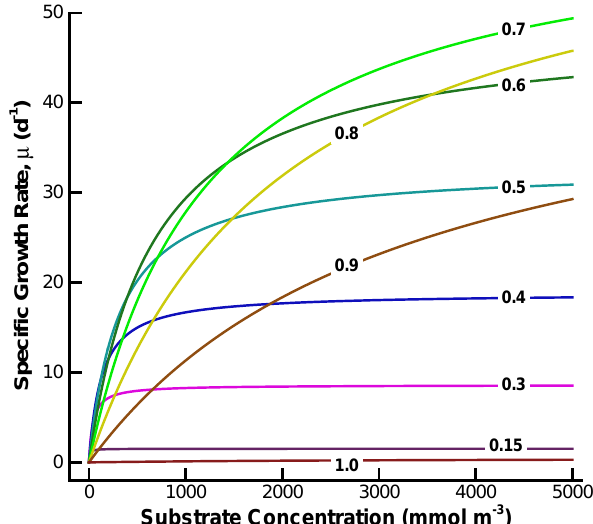
Fig. 2. Specific growth rate as a function of substrate concentrations based on Eqs. (4) and (5) for different values for ε (0.15, 0.3, 0.4, 0.5, 0.6, 0.7, 0.8, 0.8, 1.) using the universal kinetic parameters values of 350d − 1 and 5000mmolm − 3 for ν * and κ * ,